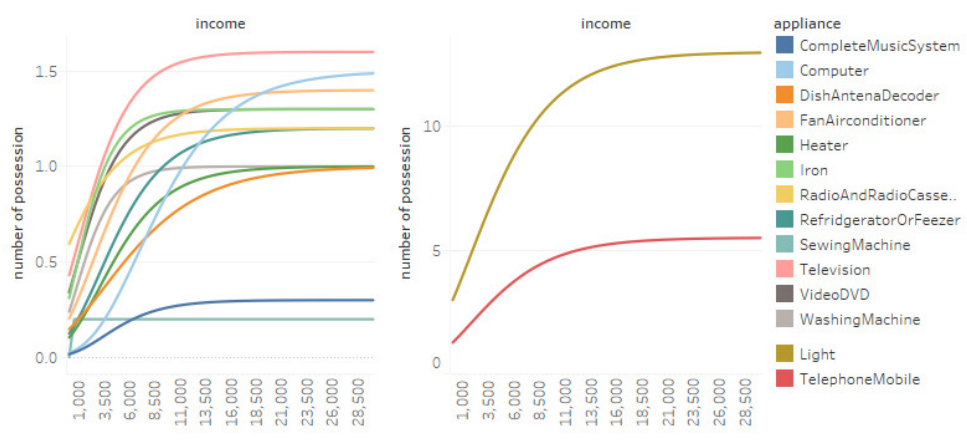
Figure 3. Annual household income and number of owned appliances per